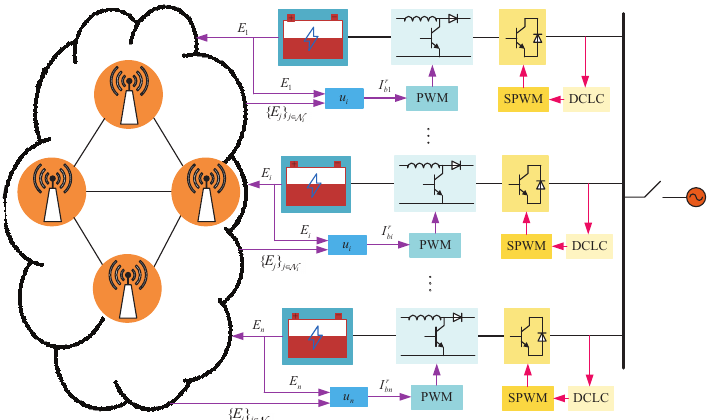
Figure 1. A grid-connected multi-BESS